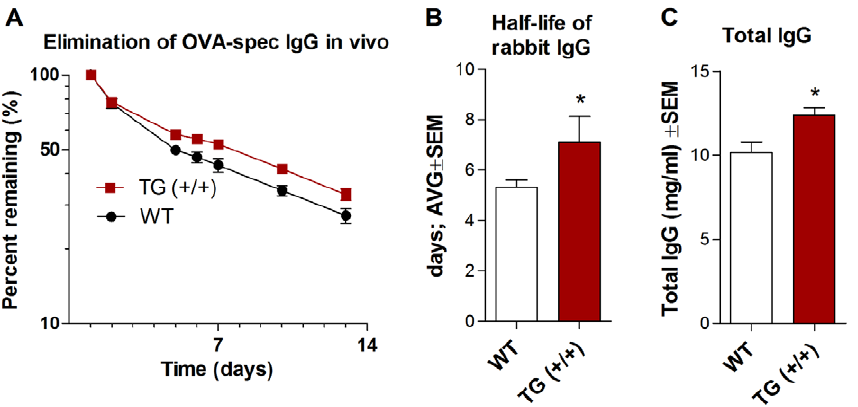
Figure 8. Reduced IgG catabolism in Tg rabbits that carry two extra copies of the rabbit FcRn. We have analyzed the half-life of rabbit IgG in Tg (homozygous; + / + ) and wt rabbits from days 2–13 after injecting OVA-specific rabbit IgG i.v. into these animals. A–B. Our analysis showed that the Tg rabbits have increased serum persistence of rabbit IgG as the beta phase half-lives of the IgG were 7.1 6 0.5 days (mean 6 SEM) as compared to their controls which showed 5.3 6 0.3 days. C. This difference may be even greater as non-immunized Tg rabbits have higher total IgG levels as compared to their controls. Values shown are the mean 6 SEM. (*, P , 0.05). The experiment was repeated two times with similar results.